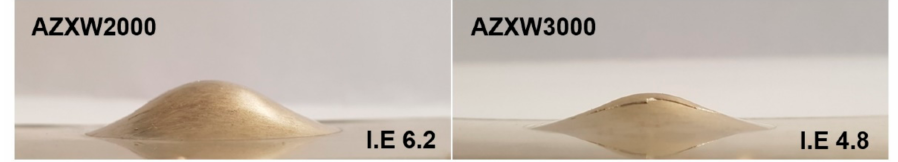
Figure 2. Appearances of the Erichsen samples of the AZXW2000 and AZXW3000 sheets, respectively.